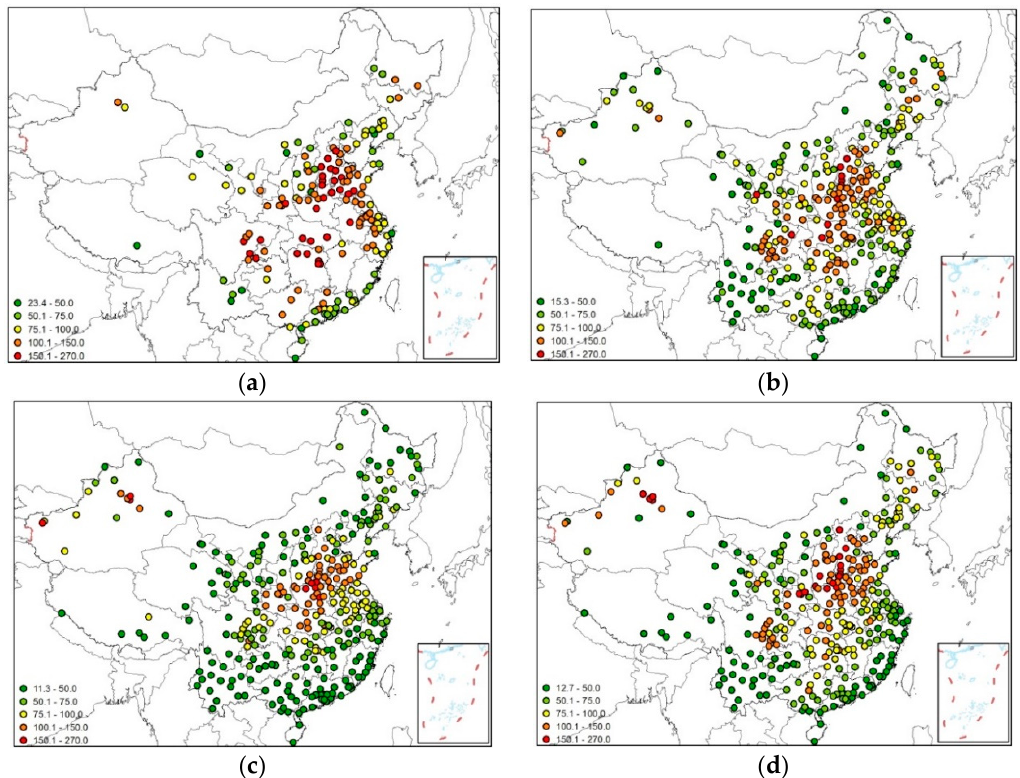
Figure 3. Monitoring concentration of PM 2.5 (µg m − 3 ) in ( a ) January 2014, ( b ) January 2015, ( c ) January 2016 and ( d ) January 2017.